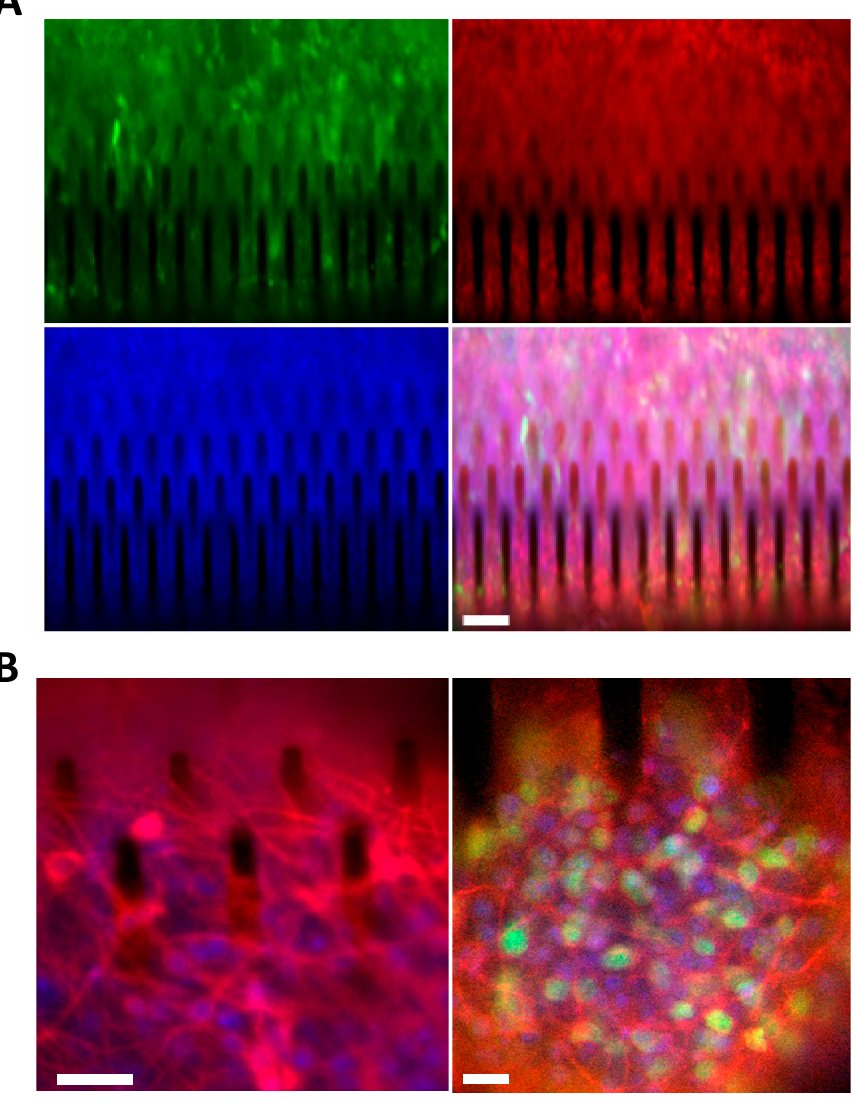
Figure 8. hCPs seeded on silicon micropillar arrays preserve their cortical regional identity and upon exposure to differentiative conditions, generate cortical glutamatergic neurons. ( A ) eGFP +ve hCPs cultured for 14 days on 3D silicon devices preserve the expression of the cortical progenitor marker TBR2 (red). Nuclei are stained with Hoechst (blue). Scale bar: 50 µm. ( B ) hCPs cultured for 5 days on 3D silicon devices and then exposed for 35 days to differentiative conditions maturate into cortical glutamatergic neurons. Left: cultures stained for the pan-neuronal neuronal marker β 3-TUBULIN (red). Nuclei are stained with Hoechst (blue). Scale bar: 10 µm. Right: cultures stained for the mature neuronal marker MAP2 (red) and for the cortical neuronal marker CUX1 (green). Nuclei are stained with Hoechst (blue). Scale bar: 10 µm.